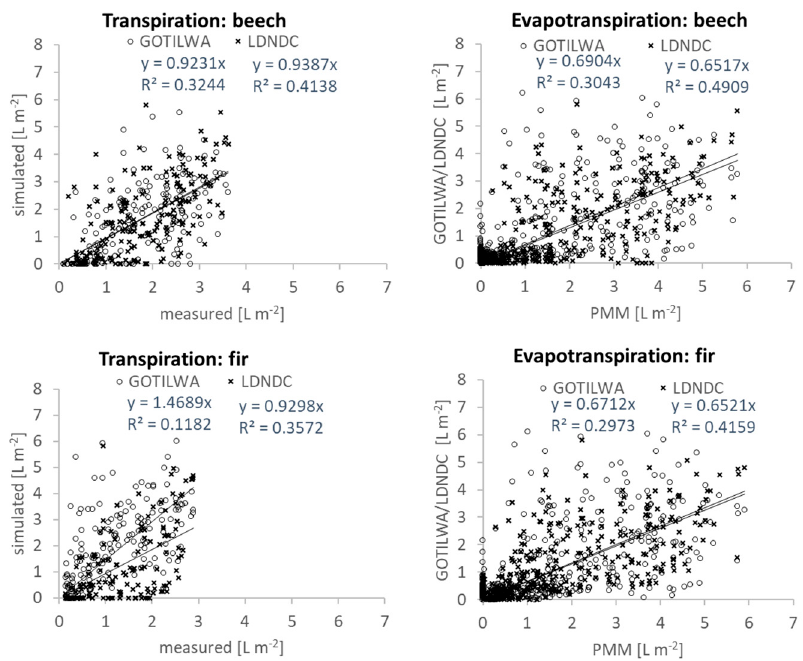
Figure 6. Simulations of transpiration compared with averaged sap-flux measurements from single trees ( left ) and comparison of simulated evapotranspiration results with estimates based on the Penman-Montheith method ( right ), separately calculated for beech ( top ) and fir ( bottom ) stands.